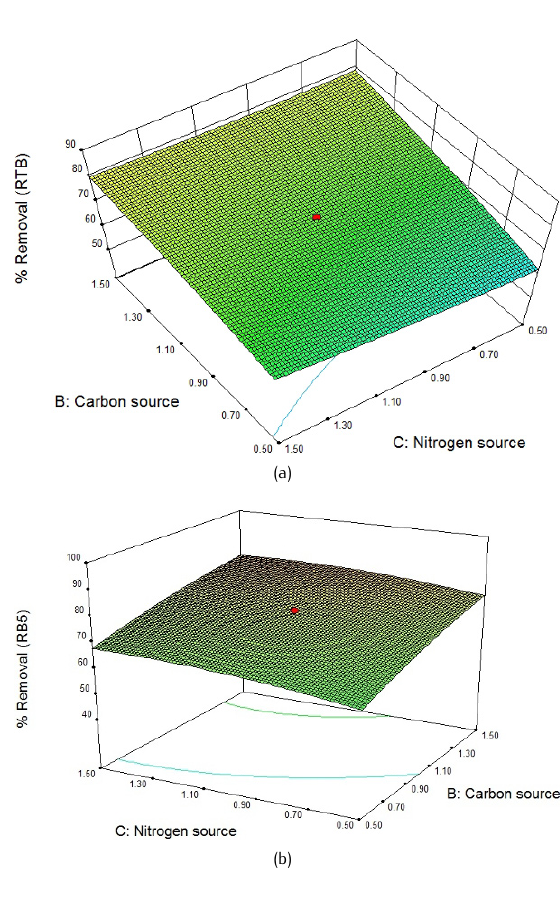
Figure 5. Biodecolourization of dyes on 3-D graphics for response surface optimization Carbon source versus Nitrogen source (a) RTB and (b) RB5.